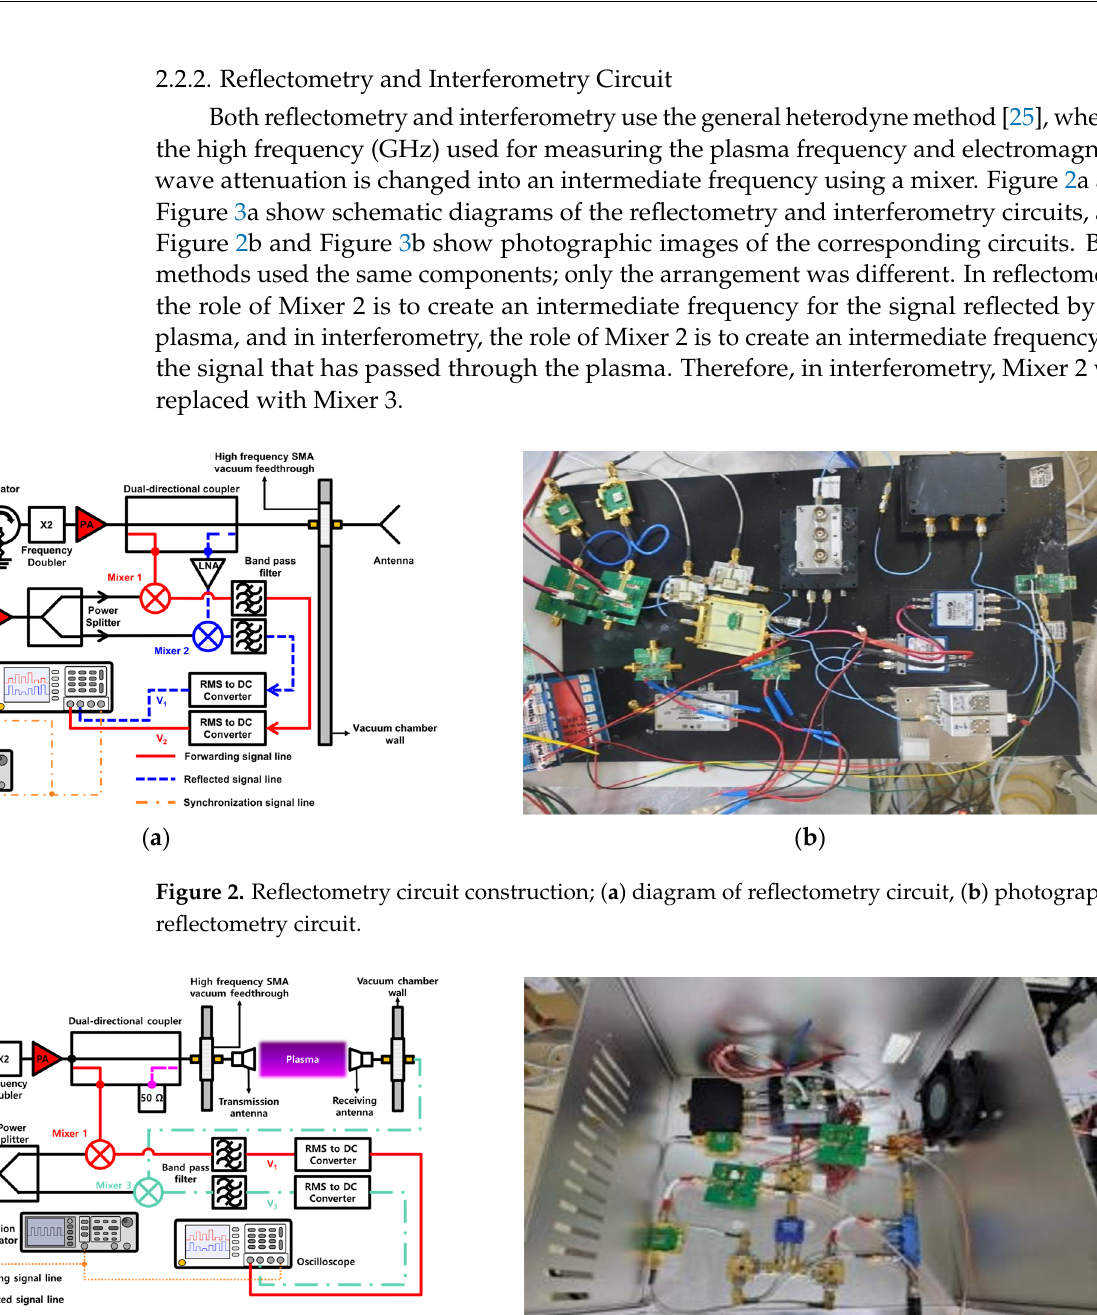
Figure 3. Interferometry circuit construction; ( a ) diagram of interferometry circuit, ( b ) photograph of interferometry circuit.